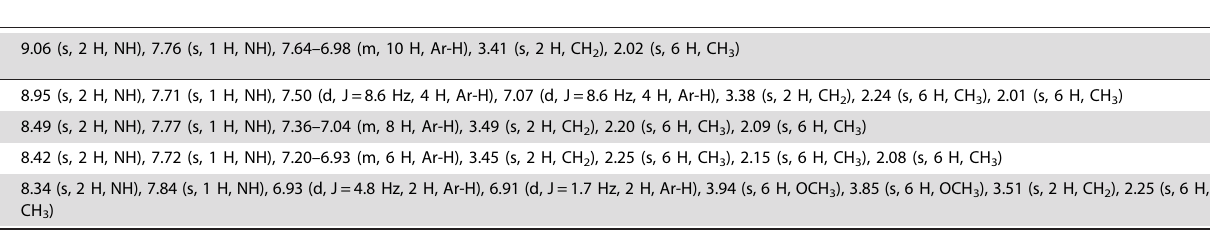
Table 10. H NMR data u f compounds